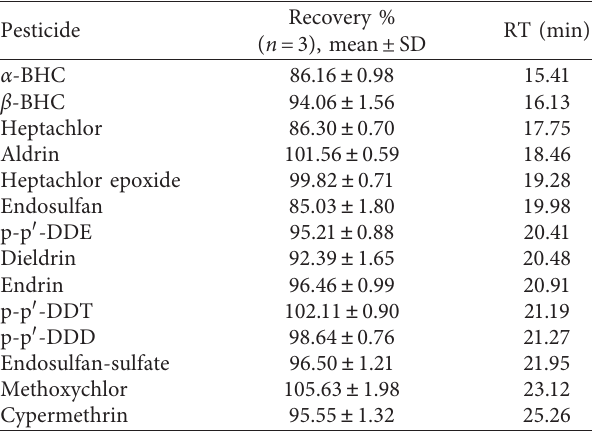
Table 1: Retention time and recovery (%) values of each target